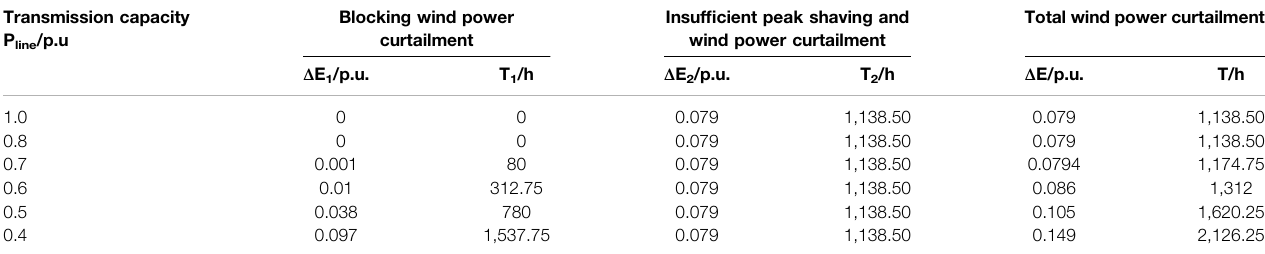
TABLE 1 | Δ P, Δ E and duration T under different Pline. Transmission capacity P line /p.u